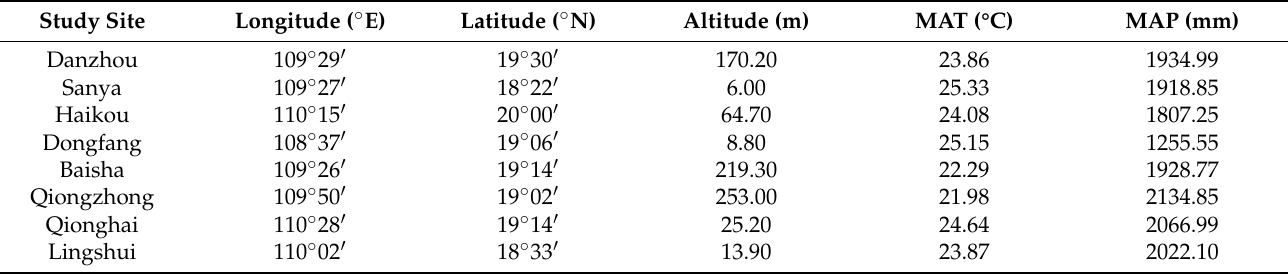
Figure A1. Pearson correlation coefficient of geographic and climatic factors. * indicates significant differences at p < 0.05. The circle in the figure represents the correlation coefficient, red represents positive correlation, blue represents negative correlation. Lon., longitude; Lat., latitude; MAT, mean annual temperature; RST, rainy season temperature; MAP, mean annual precipitation; RSP, rainy season precipitation; RH, relative humidity; WS, wind speed. Table A1. Hainan meteorological station.